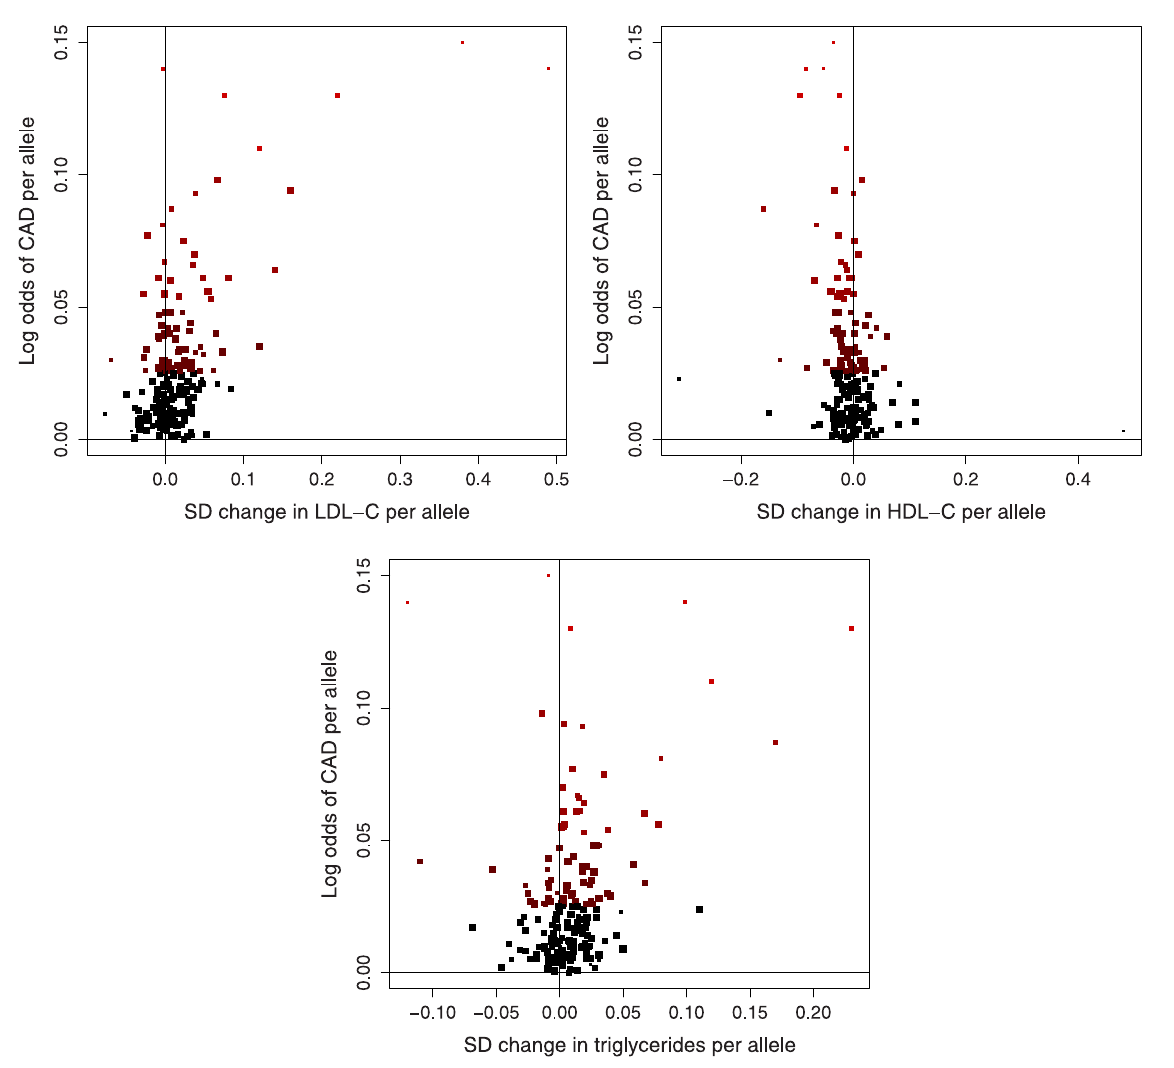
Figure 2. Associations of lipid-related genetic variants with lipid fraction and CAD risk. Association of coronary artery disease (CAD) risk- increasing alleles of 185 genetic variants with odds of CAD, and with each of low-density lipoprotein cholesterol (LDL-c), high-density lipoprotein cholesterol (HDL-c) and triglycerides in turn (brightness and size of points: brighter points correspond to stronger associations with CAD risk, larger points correspond to more precise estimates). Note that some points are overlapping.